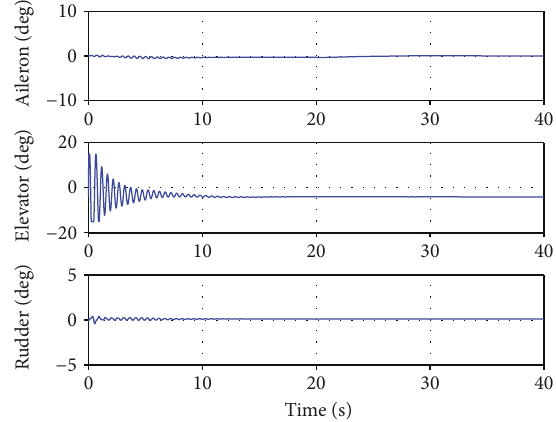
Figure 15: Control surface de fl ection angle when considering the neural network in scenario 2.